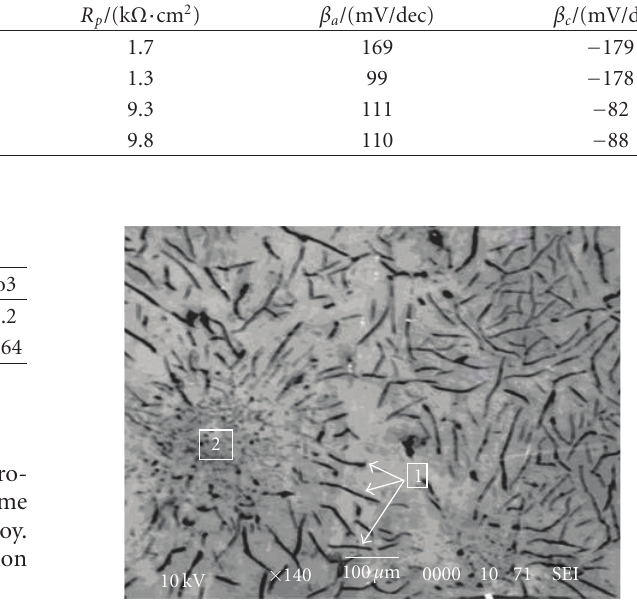
Figure 5: Co2 electron micrograph showing graphite (1) and γ Fe/C eutectic